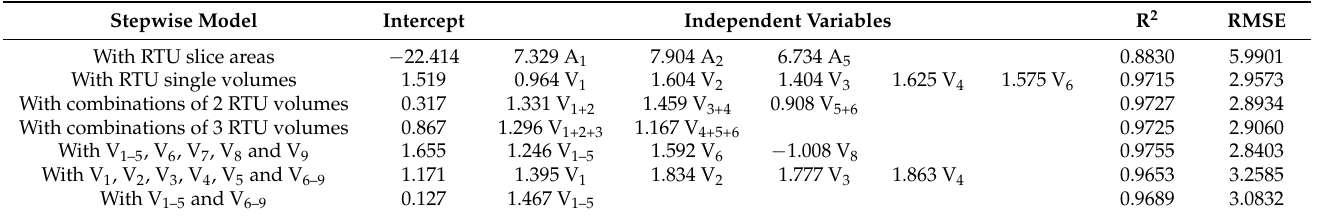
Table 3. Best models for predicting fillet volume, obtained after stepwise multiple regression with k-fold cross-validation, considering area and volume measurements (n = 44) *.